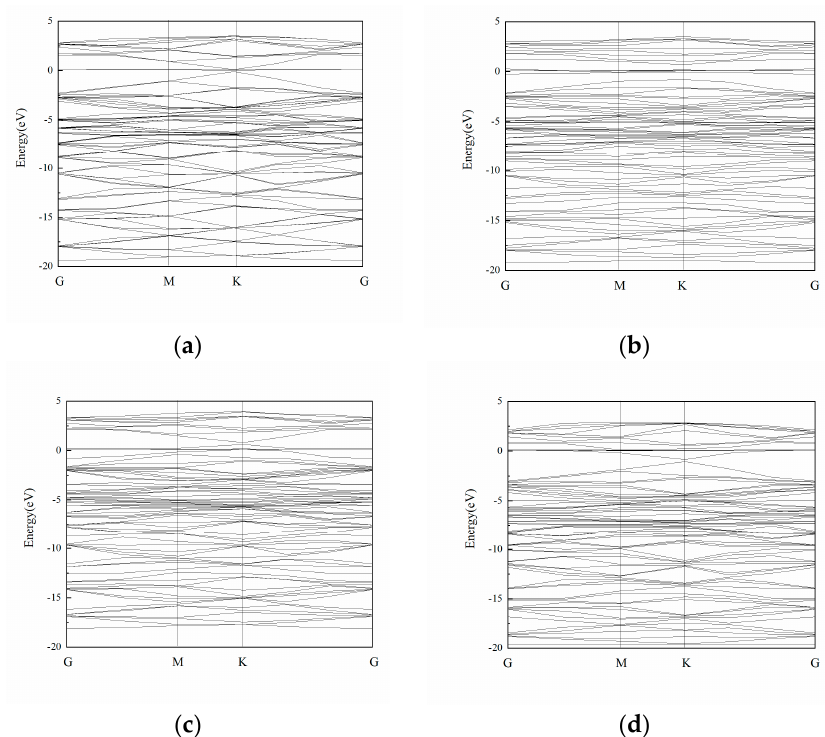
Figure 3. Band structure: ( a ) Pristine graphene with adsorbed Al atom; ( b ) VG with adsorbed Al atom; ( c ) B-doped graphene with adsorbed Al atom; ( d ) N-doped graphene with adsorbed Al atom.